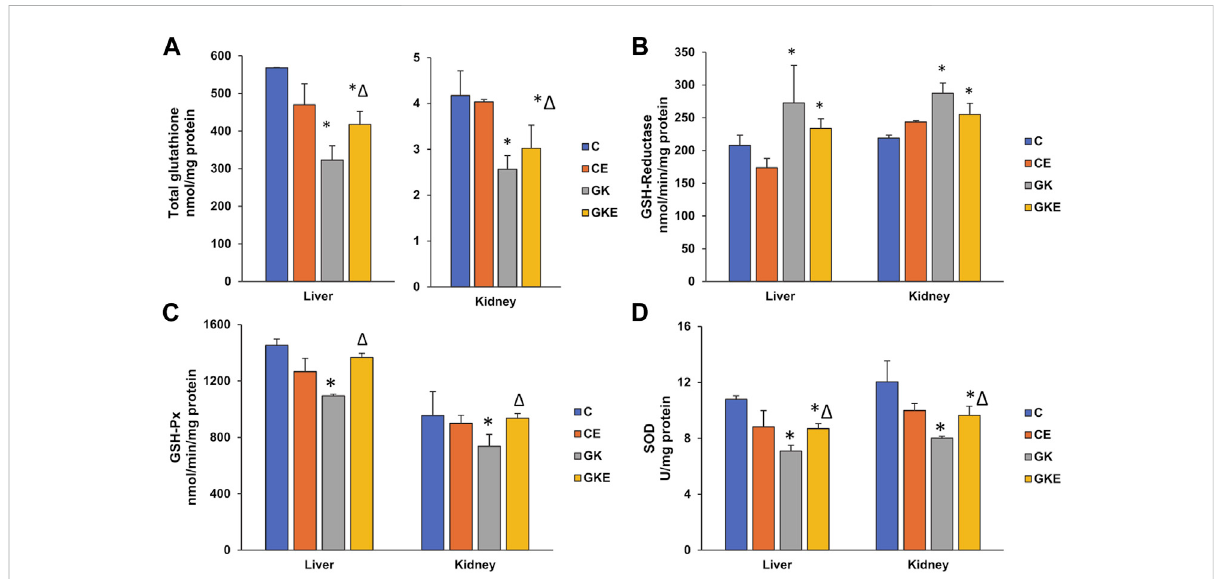
FIGURE 2 Exercise-inducedmodulationofantioxidantlevelsintheliverandkidneyofcontrolWistar(C)anddiabeticGK(GK)andexercise-trainedcontrol (CE) and GK (GKE) rats ( n = 5). Enzymatic and non-enzymatic antioxidant levels were analyzed in the different sub-groups of control and GK rat tissues.TotalGSHlevels (A) weremeasuredintherattissuesastheenzymaticconversionofoxidizedglutathionetoreducedglutathioneusingDTNB assubstrate. Glutathionereductase (B) andGSH-Px (C) activitiesweremeasuredusingGSSG/NADPHandcumene hydroperoxideassubstrates respectively and SOD (D) activity was measured using the SOD assay kit as described in the Materials and Methods. Histogram values are mean ± of three independent experiments and statistical signi fi cance is shown as asterisks, which was fi xed as p < 0.05 (* indicates statistical signi fi cance compared with control Wistar rat tissues while Δ indicates statistical signi fi cance compared with diabetic GK rat